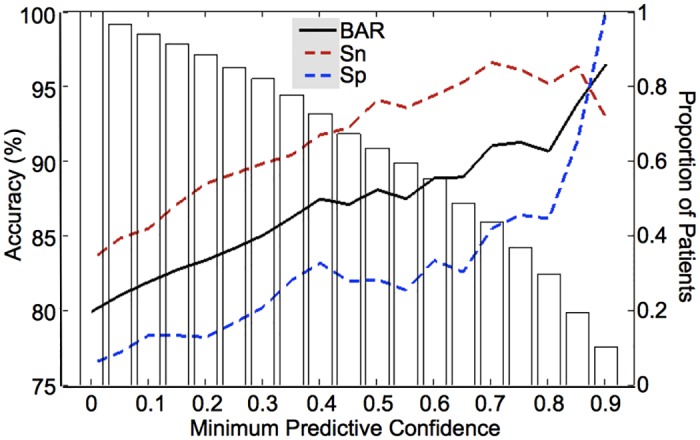
Model accuracy as a function of predictive confidence.Increasing the minimum confidence required to make predictions resulted in improved model accuracy (solid and dashed lines; left y-axis), albeit at the cost of a decreasing proportion of MCI patients for whom "high confidence" predictions could be made (white bars; right y-axis). Predictive confidence was defined as the difference between the predicted probabilities for the N-MCI and P-MCI groups. BAR = Balanced Accuracy Rate, Sn = Sensitivity, Sp = Specificity.